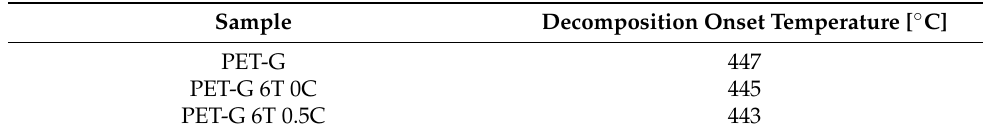
Table 5. TGA test results of PET-G and composite samples.